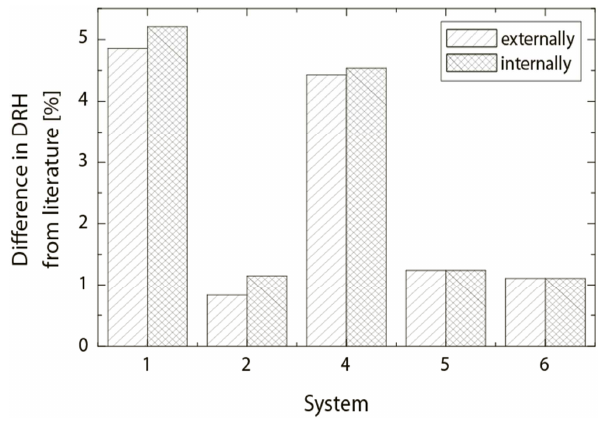
Fig. 6. Externally and internally evaluated DRH for all systems measured at a dry size of Dp